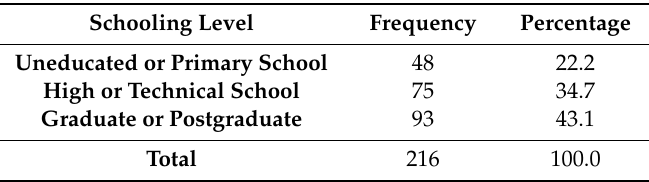
Table 3. Distribution of schooling level.